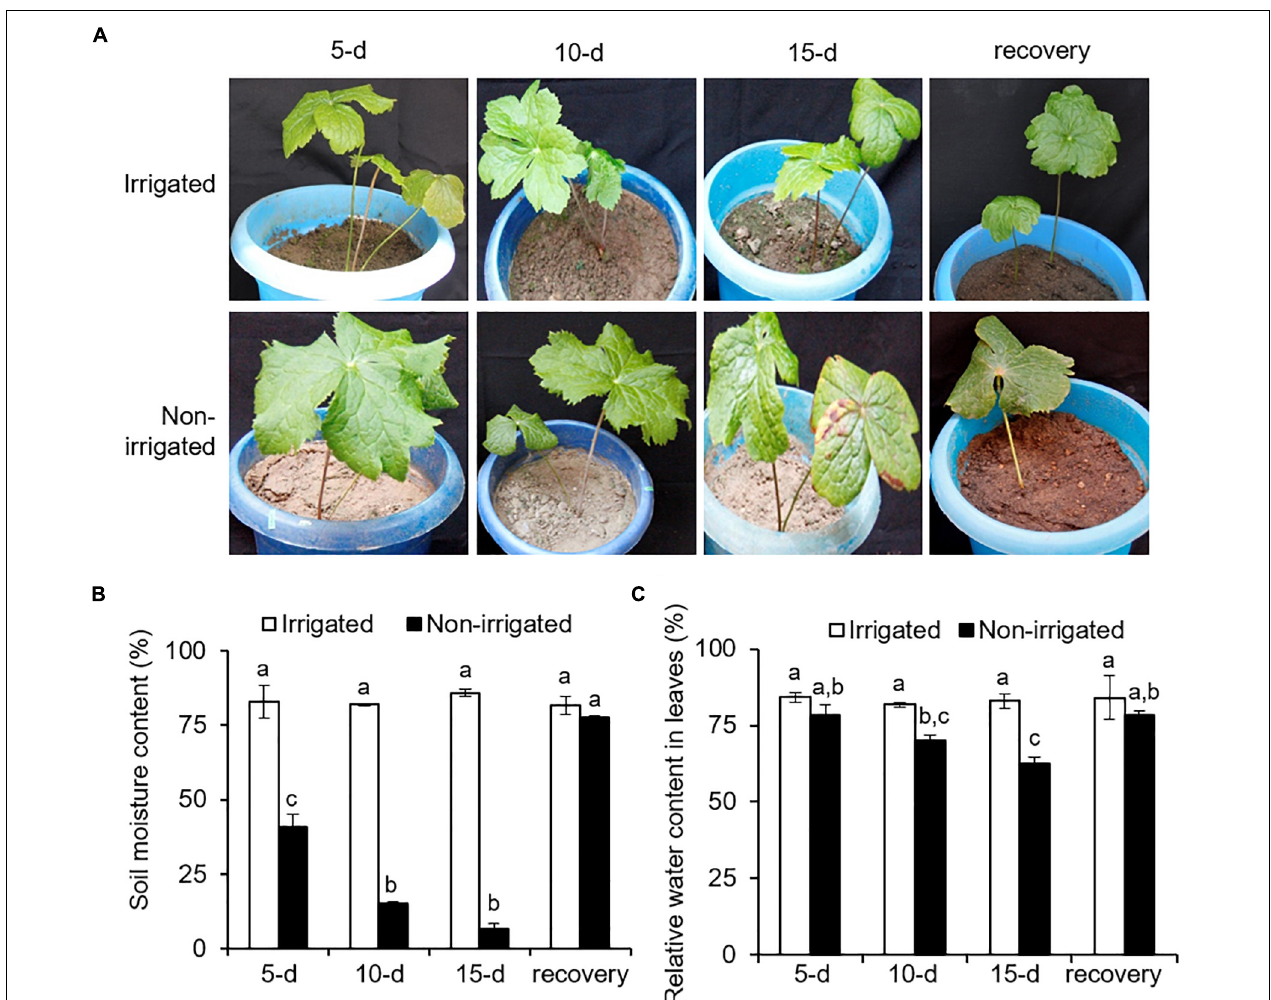
FIGURE 3 | Sinopodophyllum hexandrum plants subjected to water deprivation showed a water deficit phenotype. (A) Plant phenotype. (B) Soil moisture content. (C) Relative water content in leaves. Watering of the plants was stopped, and plant phenotype and soil moisture content were recorded for 15 days with a 5-day interval, followed by re-watering for 15 days (recovery). Plants irrigated frequently served as control. In panels (B,C) , data values show mean ± SE of three independent biological replicates. Lowercase letters represent statistical significance of differences between the mean values ( P < 0.05, Duncan’s multiple comparison